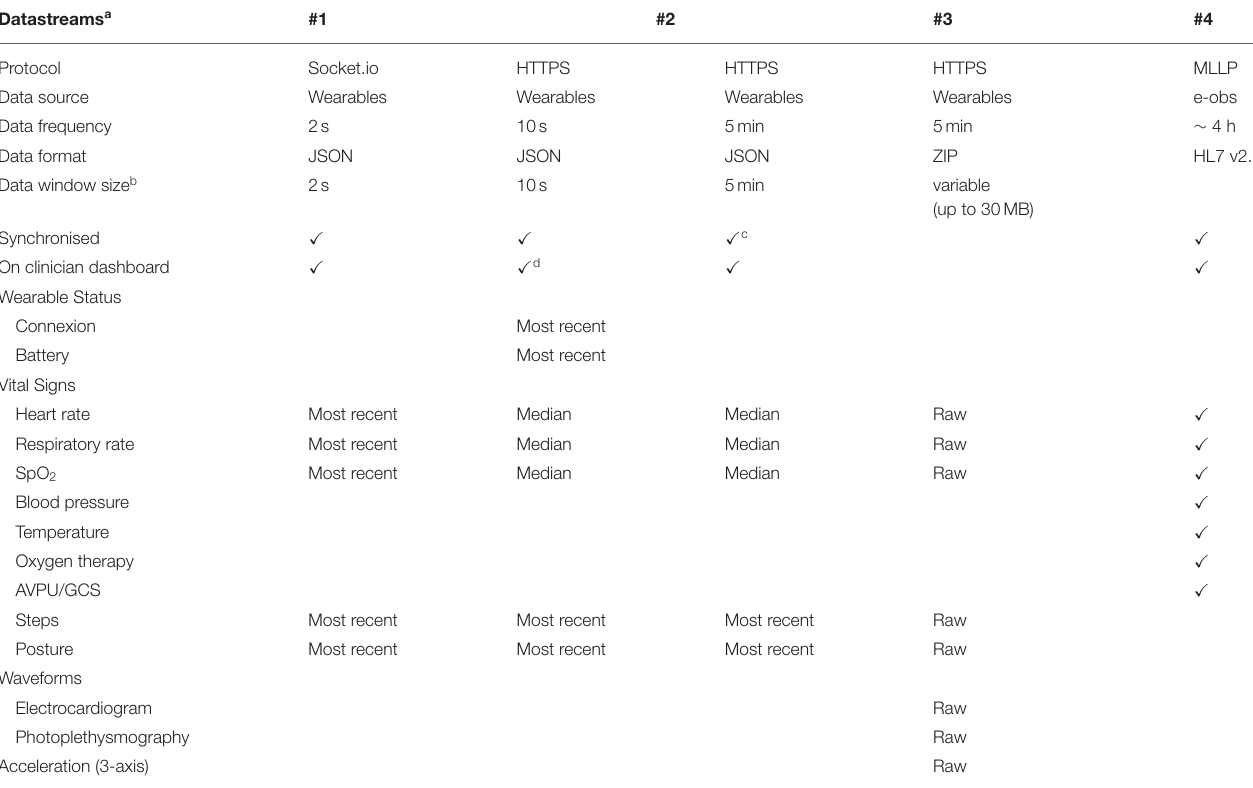
TABLE 1 | Technical specification of the datastreams sent from the app or from the e-obs hospital system into the vHDU system version 0.2. Datastreams a Protocol